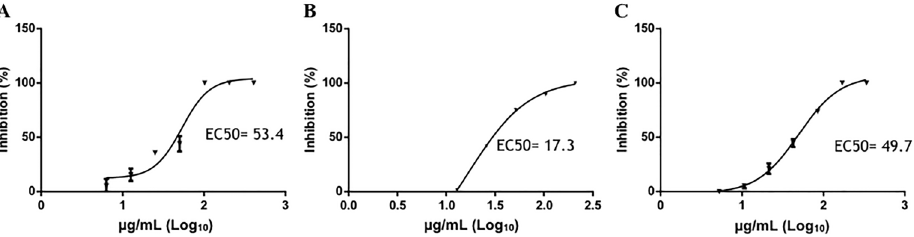
Figure 6. Plaque inhibition analysis of saponins against yellow fever virus in the virucidal assay. The virus was treated with 2-fold serial dilutions of saponins S1 ( A ), S2 ( B ), and S3 ( C ) isolated from the ethanolic extract of S. sisymbriifolium roots for 1 h. The treated yellow fever virus was used to infect monolayers of Vero E6 cells growing in a 24-well plate for 7 days. The number of plaques in the wells with cells infected with the treated virus was compared with the number of plaques in the wells with cells infected with the untreated virus to determine the percentage of plaque reduction. The 50% maximal effective concentration (EC 50 value) of the saponins was determined by nonlinear regression analysis. The data are reported as means ± SE of quadruplicate wells.